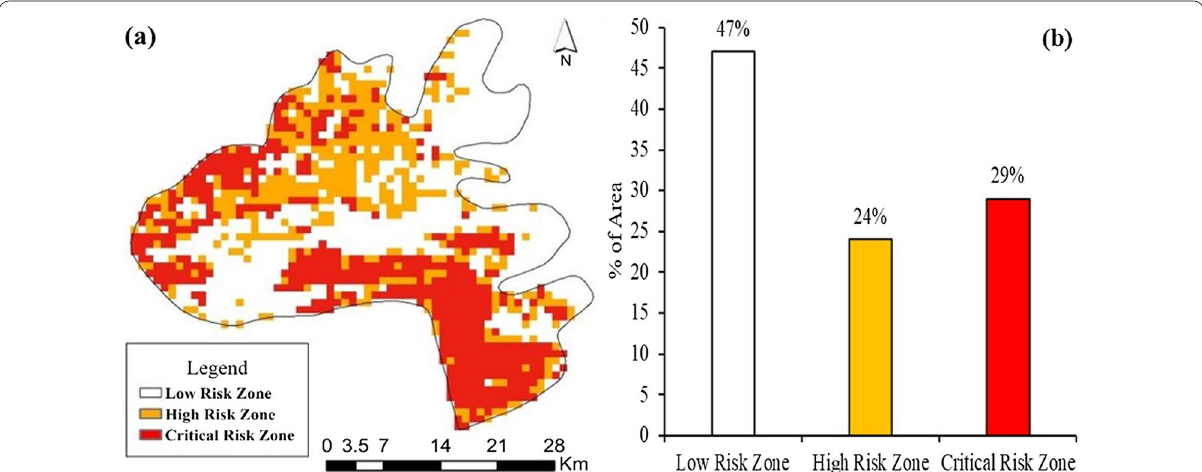
Fig. 10 Map illustrating potential distribution range prone to invasion of L. camara in Betla National Park; ( a ) for the year 2020 and ( b ) different risk zone category wise projected potential distribution area of invasion. The map shows that the majority of the area of Betla National Park is under high to critical risk zone of L. camara